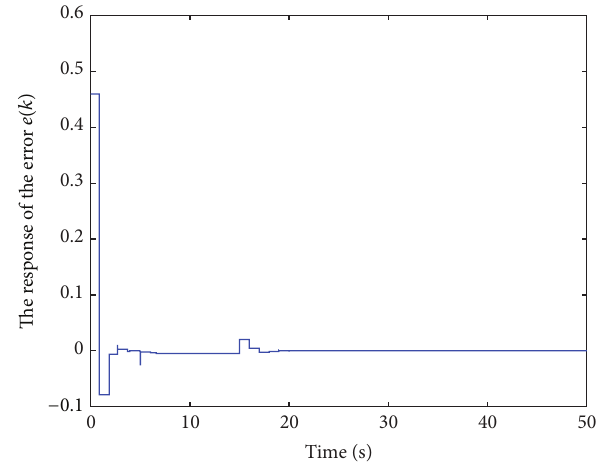
Figure 2: The response of the error 𝑒(𝑘) .